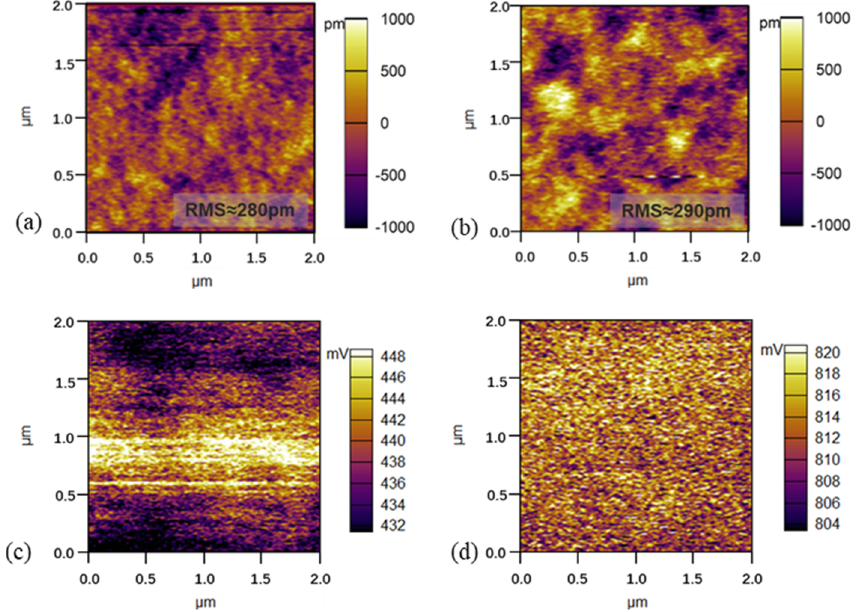
Figure 5. AFM images of ( a ) EML without PSVA, ( b ) EML with PSVA; SKPM images of ( c ) EML without PSVA, ( d ) EML with PSVA.